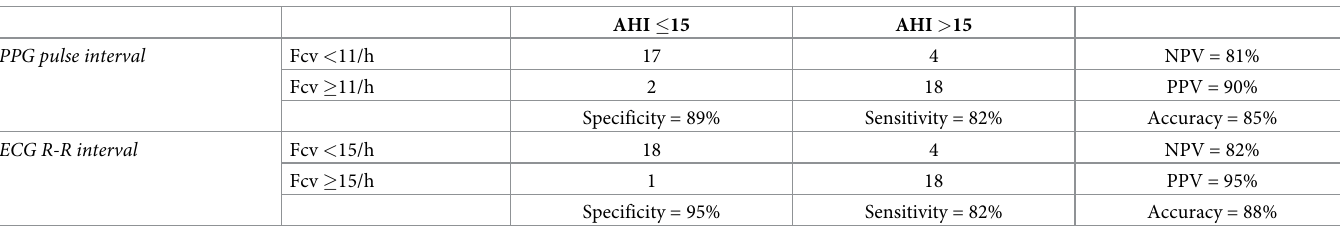
Table 5. Classification performance of PPG and ECG Fcv between patients grouped by